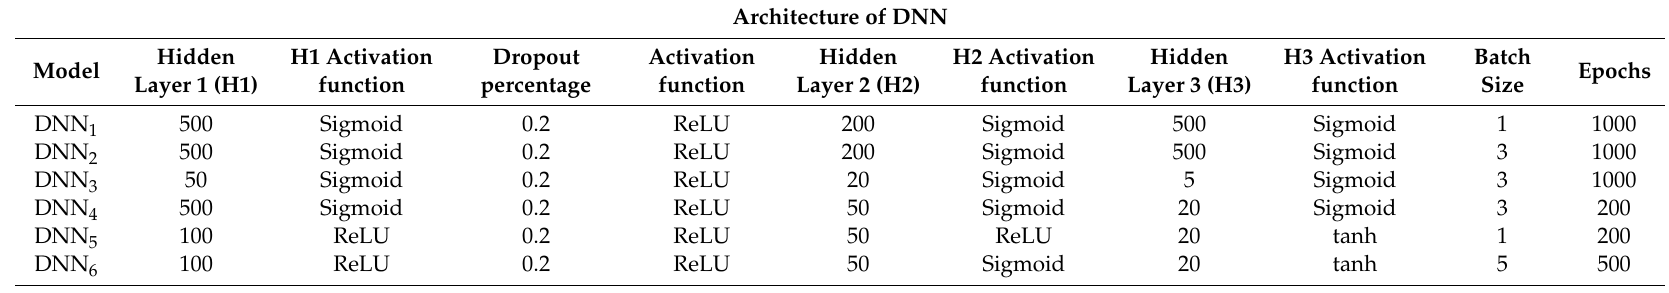
Geo ff Hinton’s adaptive learning rate method,